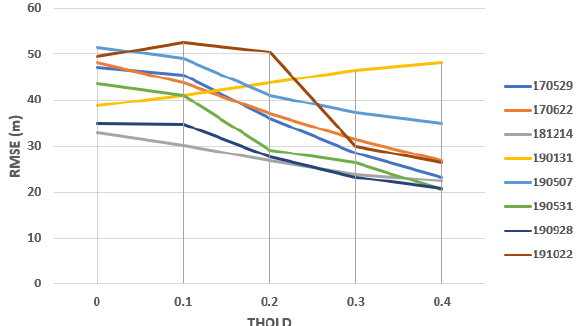
Figure 5. The RMS error of different coherence thresholds. To illustrate, the error map of pair 5 (190507) is displayed in Figure 6. The gradual color scale ranges from red over white to blue pattern with 100 m as maximum and -100 m as minimum.